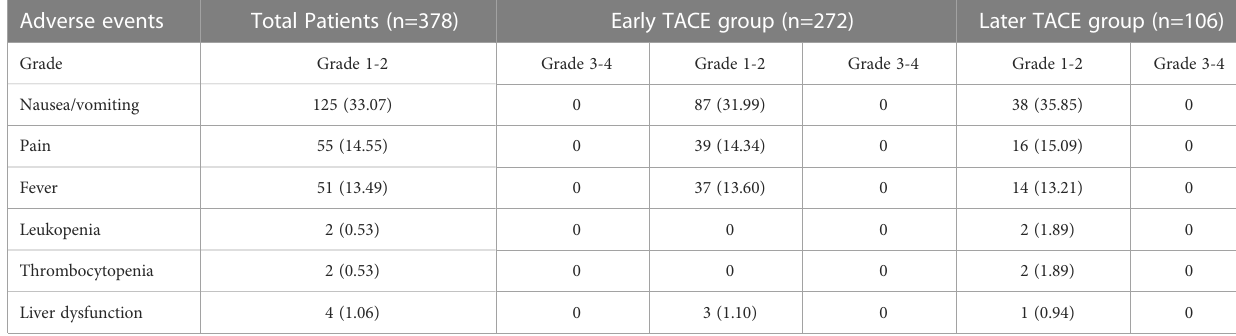
TABLE 3 The adverse events (AEs) related to PA-TACE in HCC patients. Adverse events Total Patients (n=378)